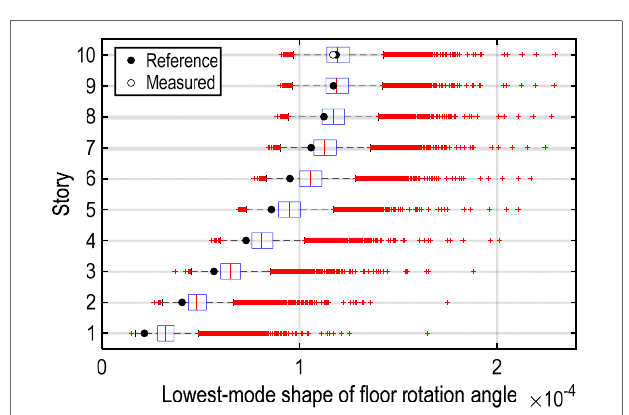
mean values of error ratios of identified stiffnesses considering the noise are almost the same compared with those without noise.